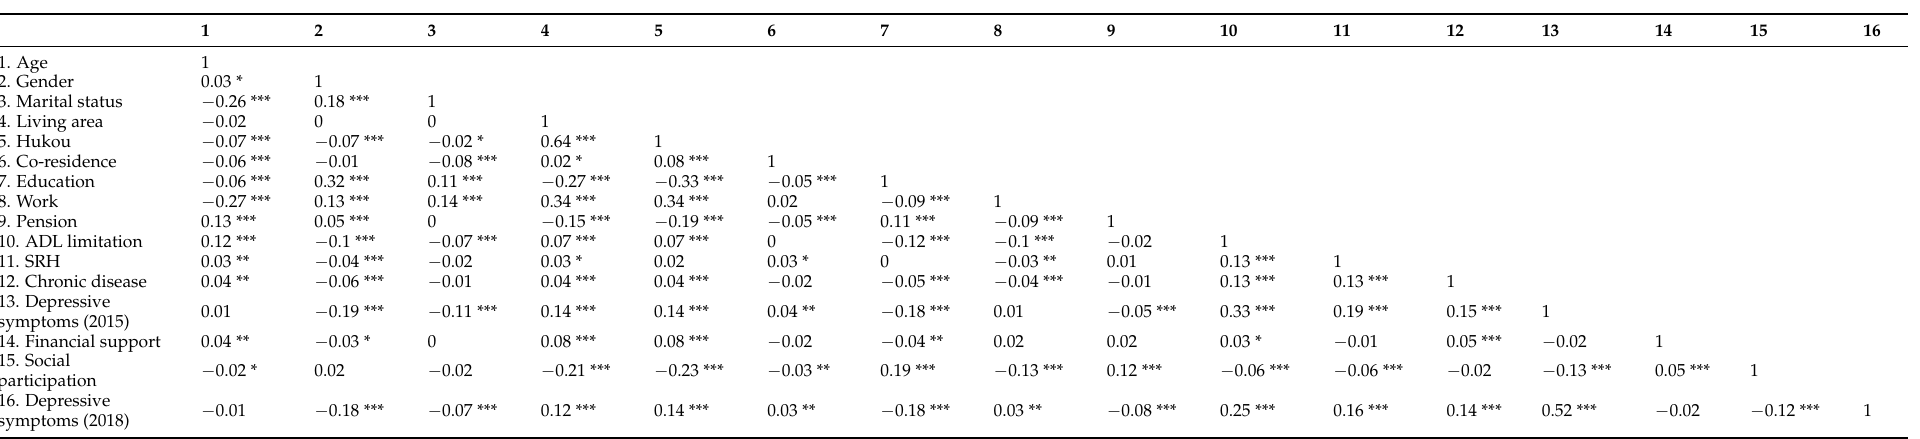
Table 2. Correlation among